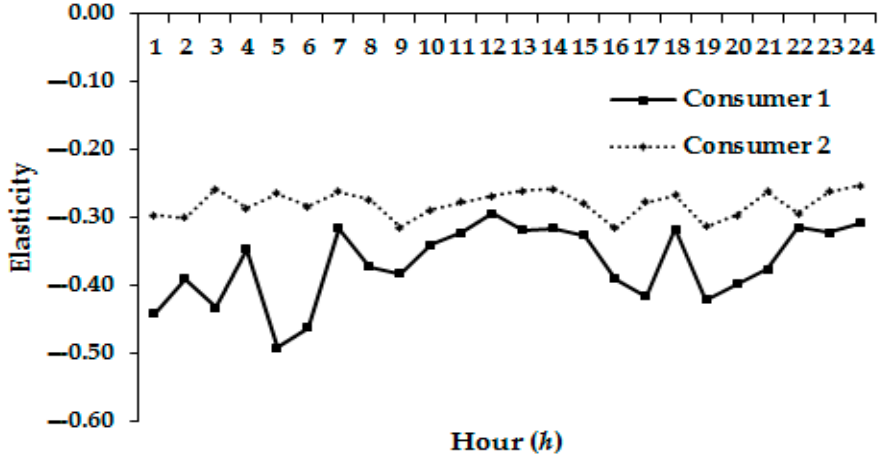
Figure 11. Daily price elasticity curves using the logarithmic model. Energies 2017 , 10 , 1407